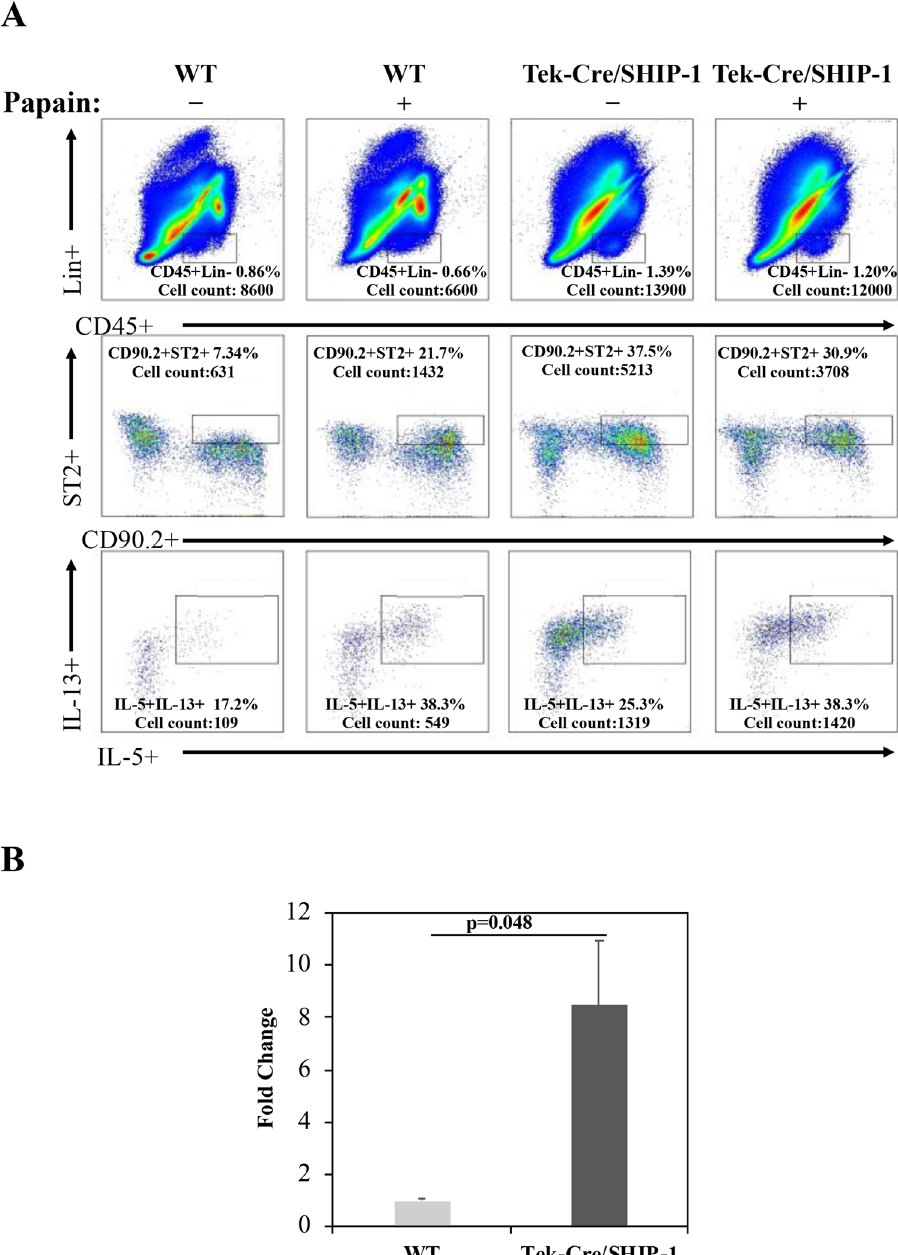
Figure 8. Increased ILC2 cells in the lung tissues of Tek-Cre/SHIP-1 mice. ( A ) Lung tissue samples of WT and Tek-Cre/SHIP-1 mice were analyzed by flow cytometry for ILC2 cells. CD45 + Lineage-ST2 + and IL-5/IL-13- producing ILC2 cells in the lung tissues of WT and Tek-Cre/SHIP-1 mice were analyzed at baseline or after Papain stimulation for 7 days. The percentage and total cell count for each sample are shown. Representative data from 3 independent experiments are shown. ( B ) Comparison of ILC2 cells in the lung of WT and Tek-Cre/ SHIP-1 mice at baseline. Shown is fold change in mice (n = 3 each group, p = 0.048 using Student’s t